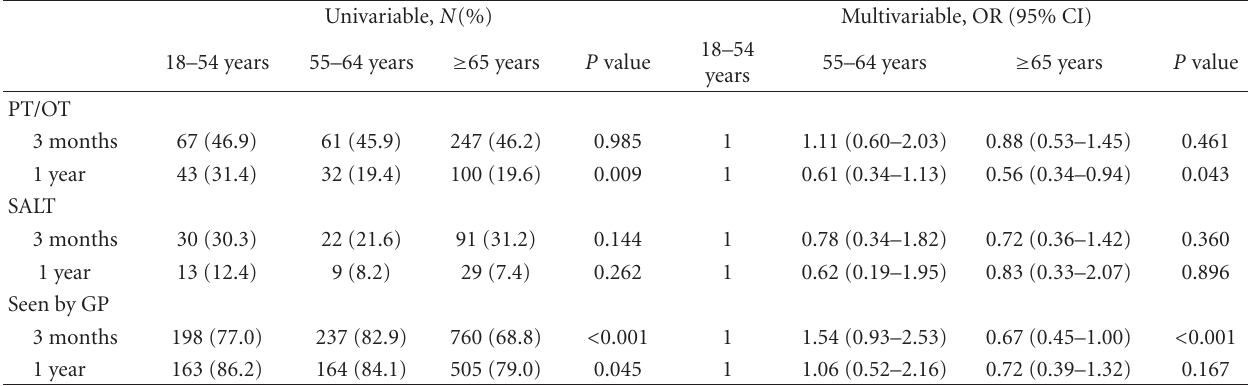
Table 5: Associations between age and continuing therapy and GP contact after